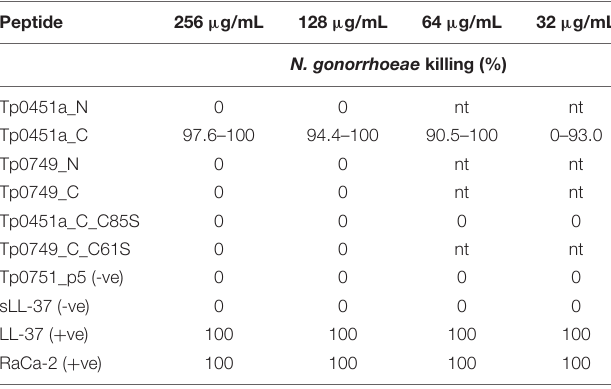
TABLE 5 | Antimicrobial susceptibility testing of T. pallidum candidate AMPCCRs against N. gonorrhoeae using a modified agar dilution method. Peptide 256 µ g/mL 128 µ g/mL 64 µ g/mL 32 µ